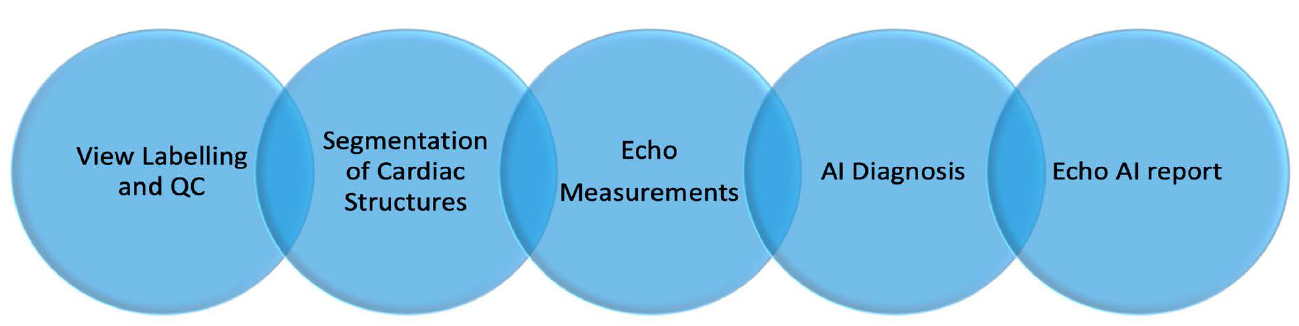
Figure 5. The flowchart of automated artificial-intelligence-empowered echo (AI-Echo) interpretation pipeline using a chain approach. QC: Quality